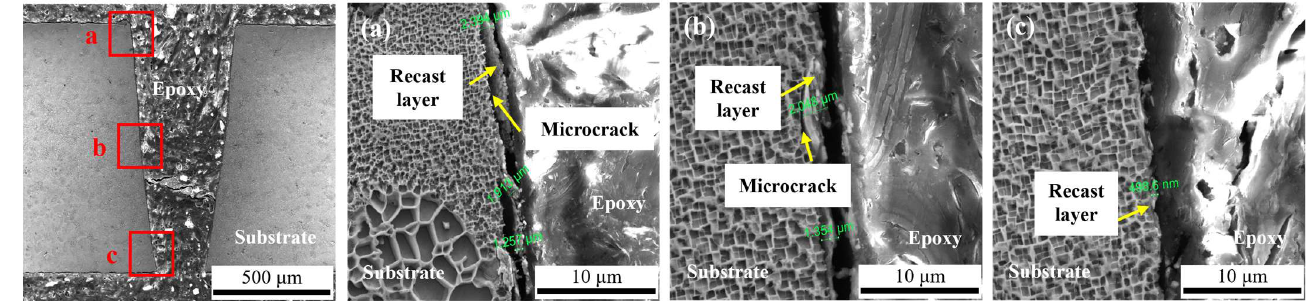
Figure 17. SEM morphologies of the hole machined by laser machining in air. ( a ) Hole entrance; ( b ) Hole middle; ( c ) Hole exit.